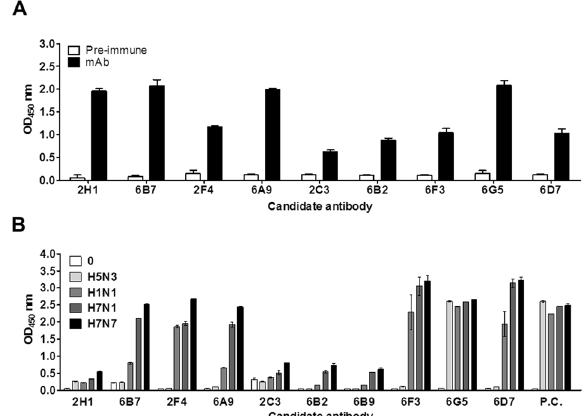
Figure 1. Development of H7 subtype-specific antibodies. The fusions were performed using mouse spleen cells inoculated with H7N9 virus rHA1. Ten hybridomas were produced. The secreted antibodies from each hybridoma were tested for recombinant antigen (H7N9 HA1 ( A ) and different influenza subtype virus ( B ) by indirect ELISA. Pre-immune, serum from a healthy mouse; P.C., positive control antibody (anti-influenza A nucleoprotein